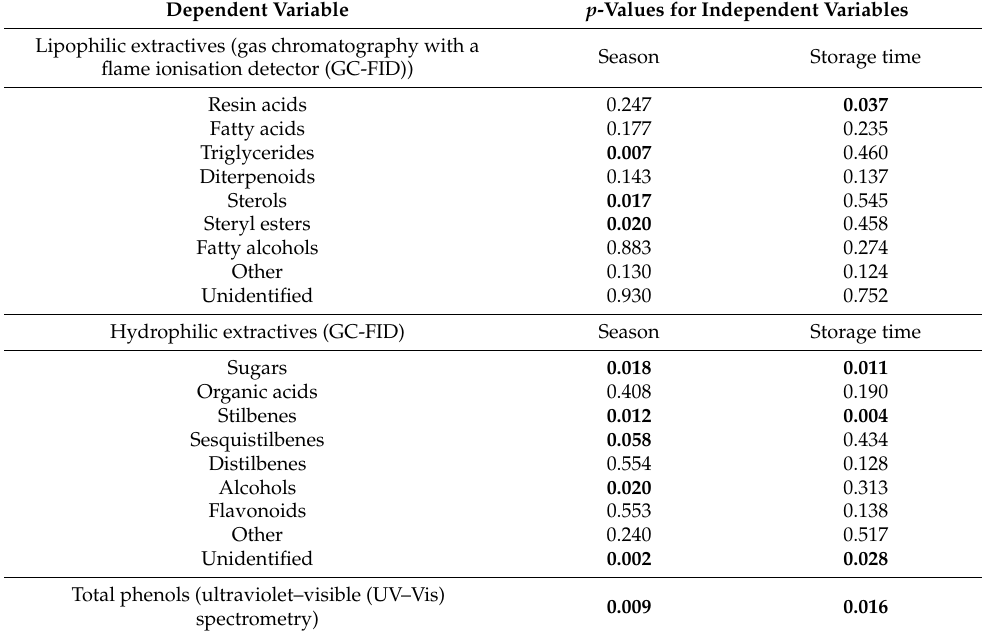
Table 7. The statistical differences ( p -values) between storage time and season with regard to the quantitative amounts of extractive groups. Results showing statistical significance are